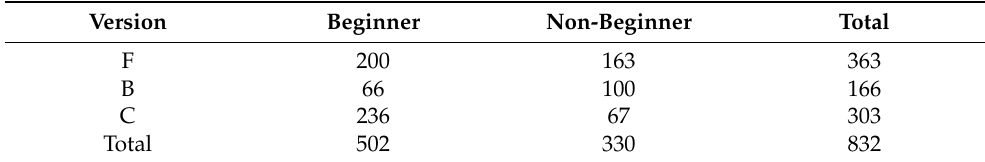
Table 6. Size of participants’ sample split by version of the app used and self-reported level of